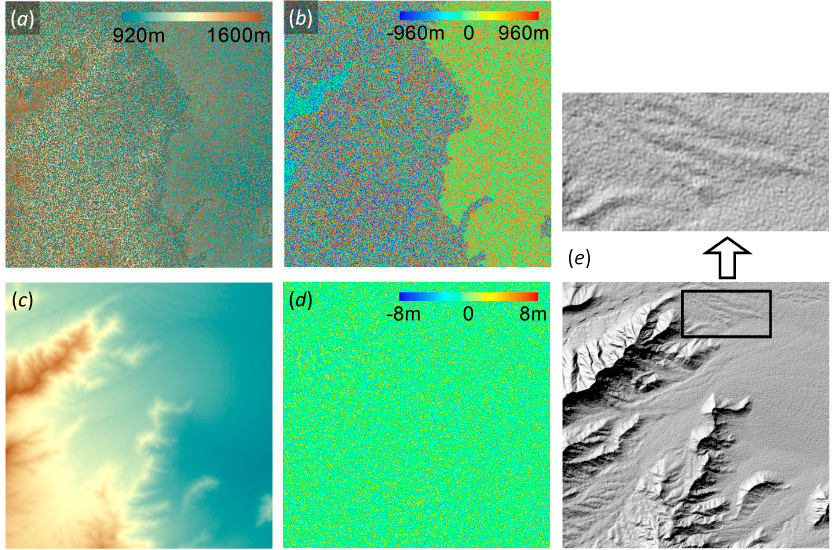
Figure 4. Multi-baseline InSAR DEMs (without atmospheric effects) and height error maps, without the prior DEM ( a , b ) and with the prior DEM ( c – e ) is the hillshade of ( c ) with the enlarged topographic details of a small area.